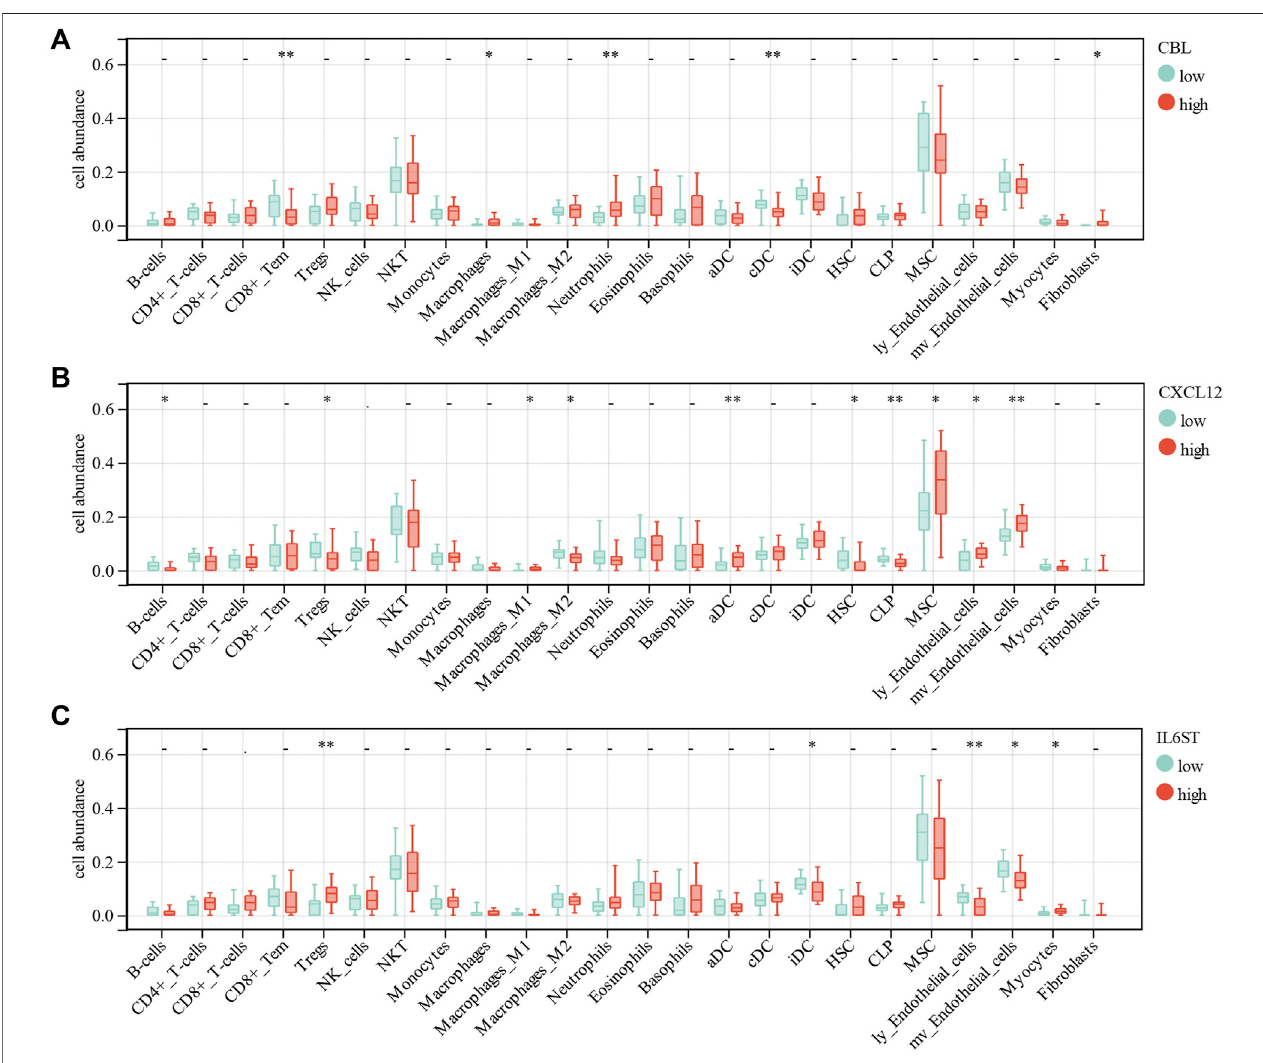
FIGURE 9 | Correlations of low/high (A) CBL, (B) CXCL12 and (C) IL6ST expression with immune cells in fi ltration in DCM.